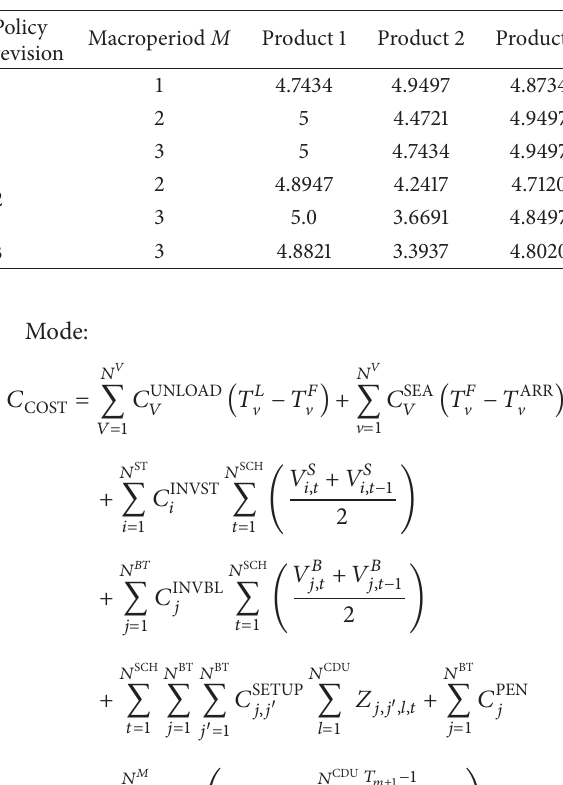
Table5:Updatesoftheproductdemandstandarddeviationsduring the process of policy